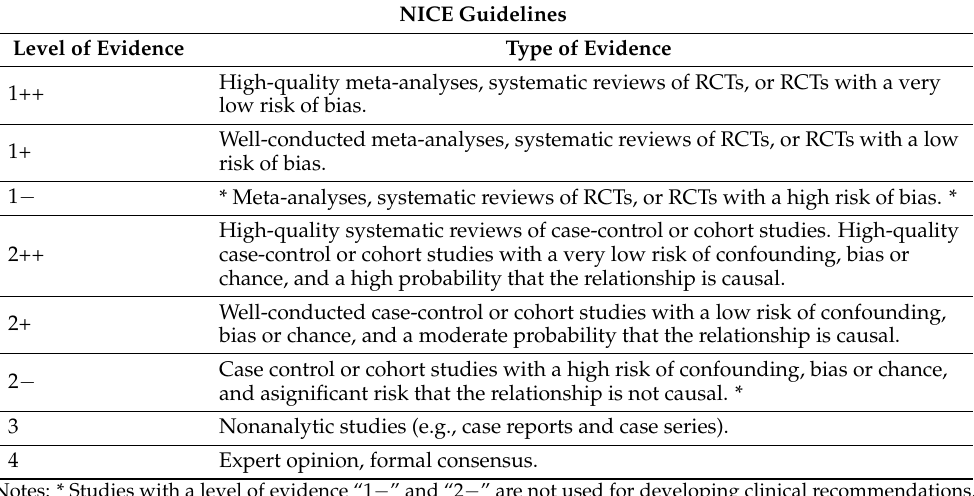
Table A2. Levels of evidence for intervention studies according to NICE guidelines